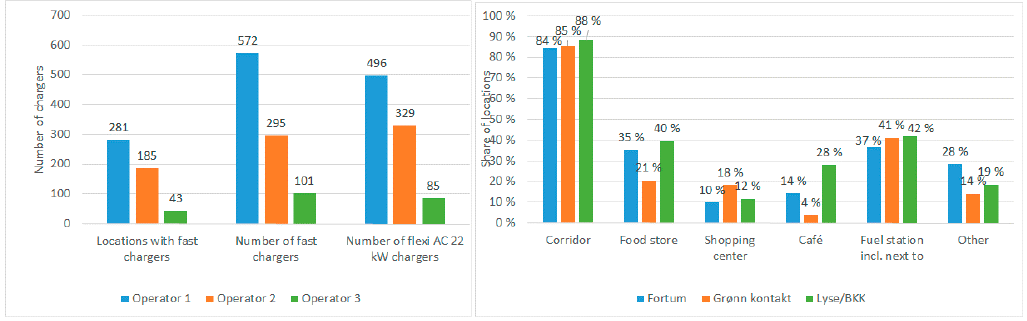
Figure 3. Number of fast chargers and location characteristics, Q1 2018, three main operators [7].